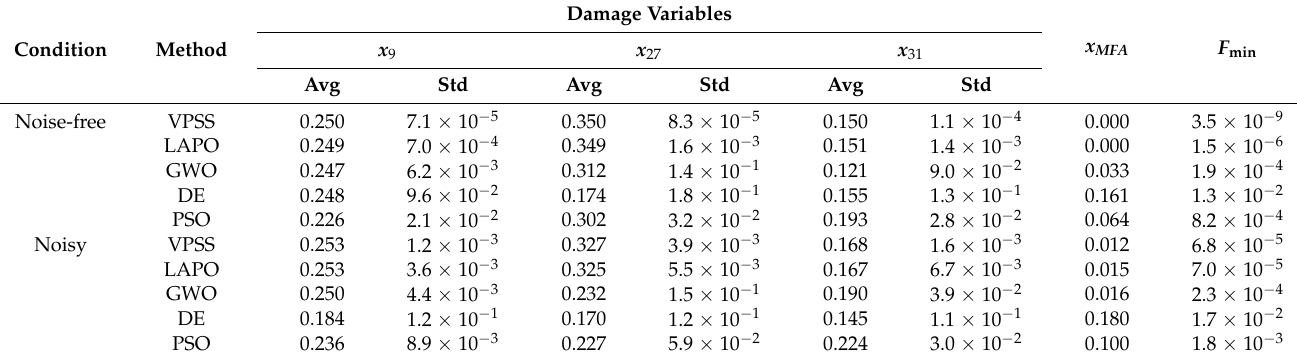
Table 5. Statistical results of the damage identification for the two-bay three-story frame.